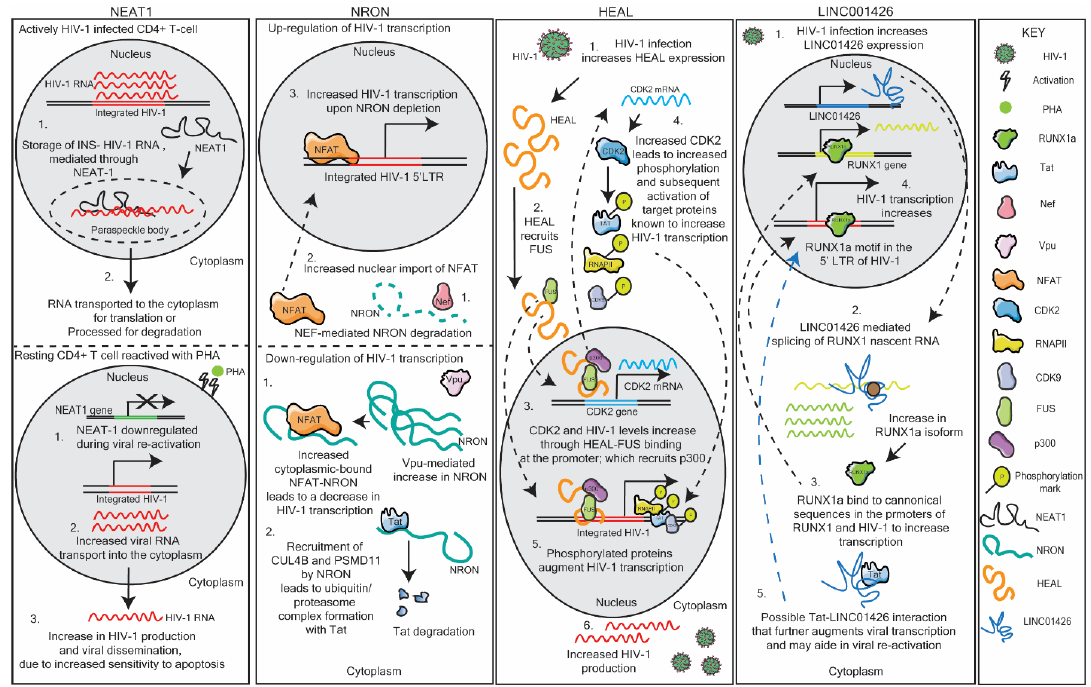
Figure 2. Schematic representation of the lncRNAs nuclear-enriched abundant target 1 (NEAT1), noncoding repressor of Nuclear Factor of Activated T cells (NRON), HIV-1 enhanced lncRNA (HEAL) and LINC01426 and their respective mechanisms of action in modulating HIV-1 replication. See text for details.